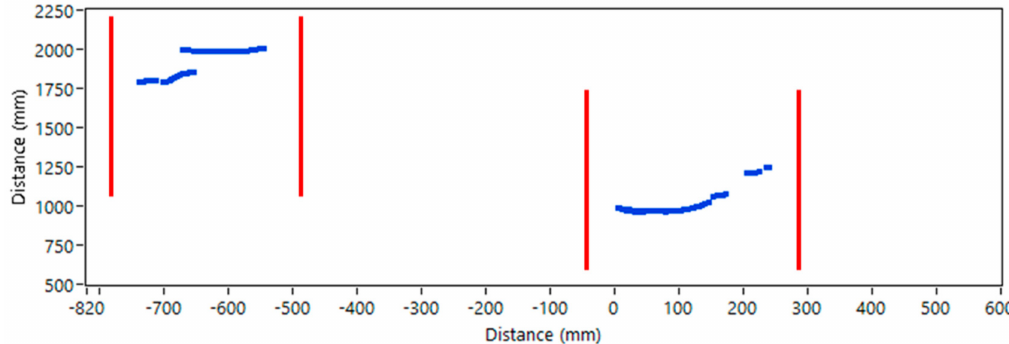
Figure 15. The scanline with marked human legs clusters. Red lines represent human pose borders, and blue plots represent segmented laser